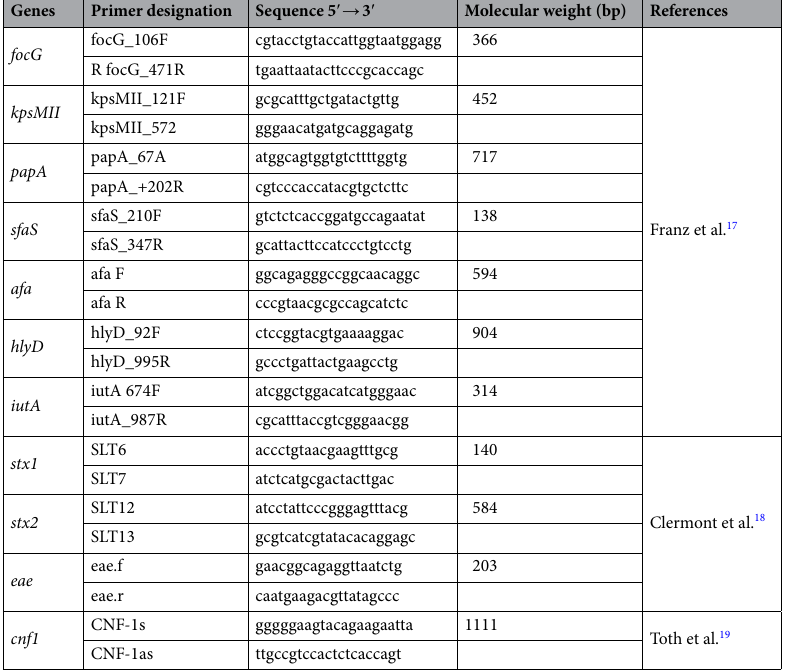
Table 1. Primer sequences for identification of virulence factors.